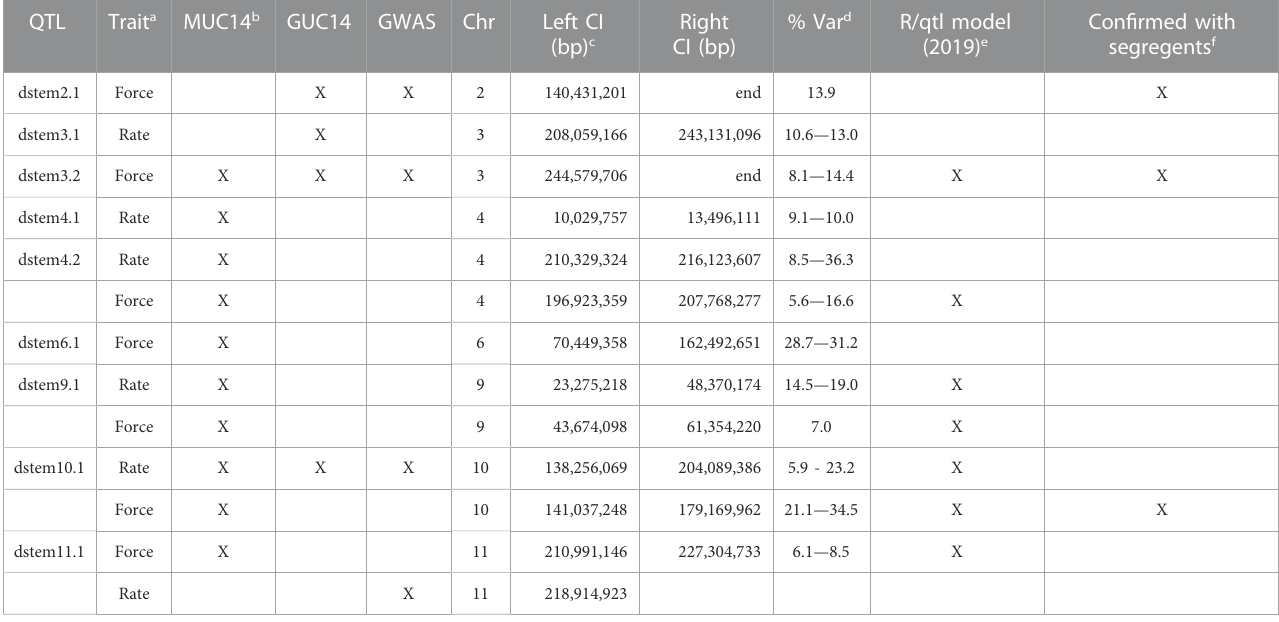
TABLE 2 Summary of quantitative trait locus (QTL) detected for destemming force and destemming rate using IcImapping, and genome wide association studies (GWAS) with data collected from both GUC and MUC populations from 2015 to 2019.